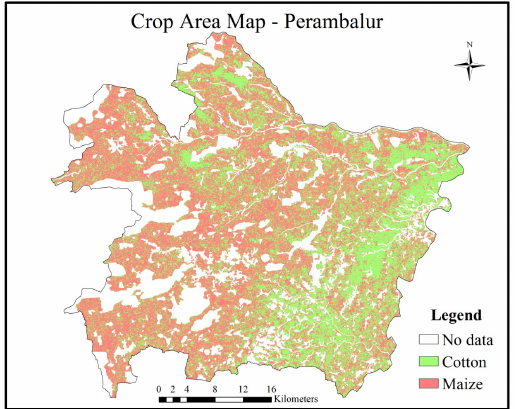
Figure 3: Crop area map as classified using Decision tree